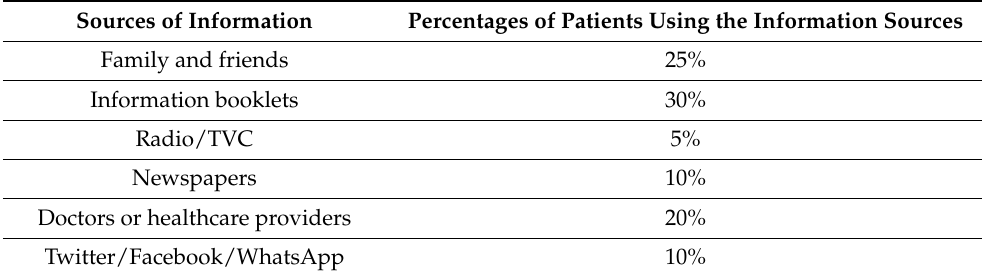
Table 3. Sources of information about bowel cancer screening programme (if you have heard of it) N = 175 (50% of total